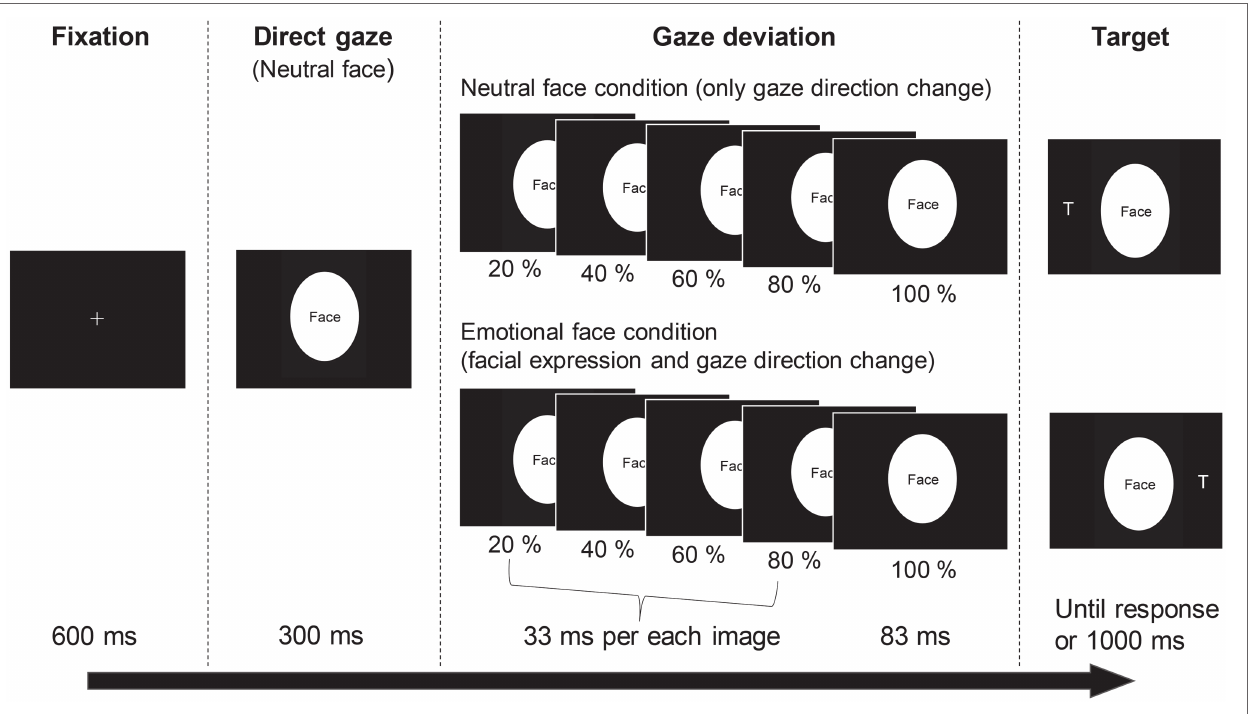
FIGURE 1 | The trial sequence of the gaze-cueing task. The cue stimuli were replaced with ‘Face’ because of a copyright restriction (see Uono et al., 2009a,b for the real facial